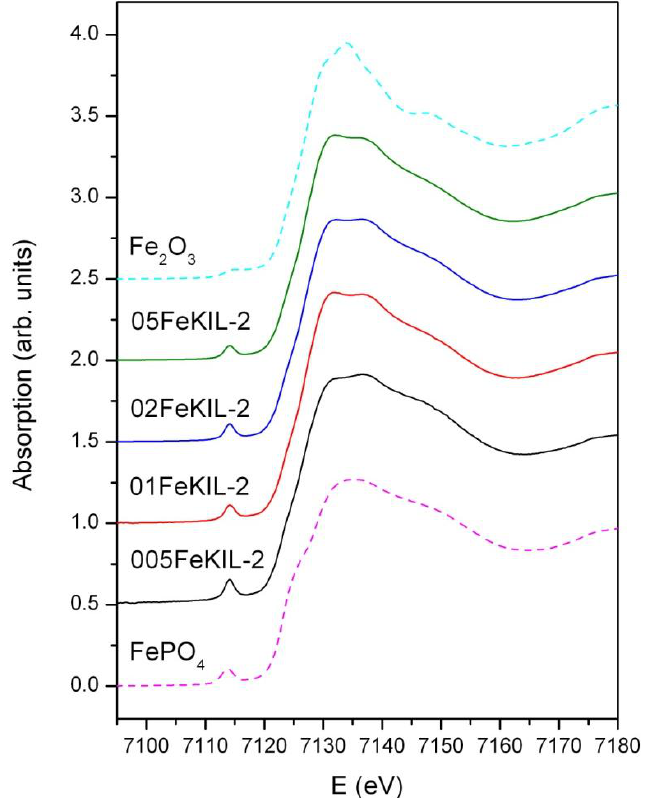
Figure 4. Normalized Fe K-edge X-Ray absorption near edge structure (XANES) data of FeKIL-2 samples and Fe reference compounds: Fe iron 3+ ions) and FePO (ferric ions in a tetrahedral 4